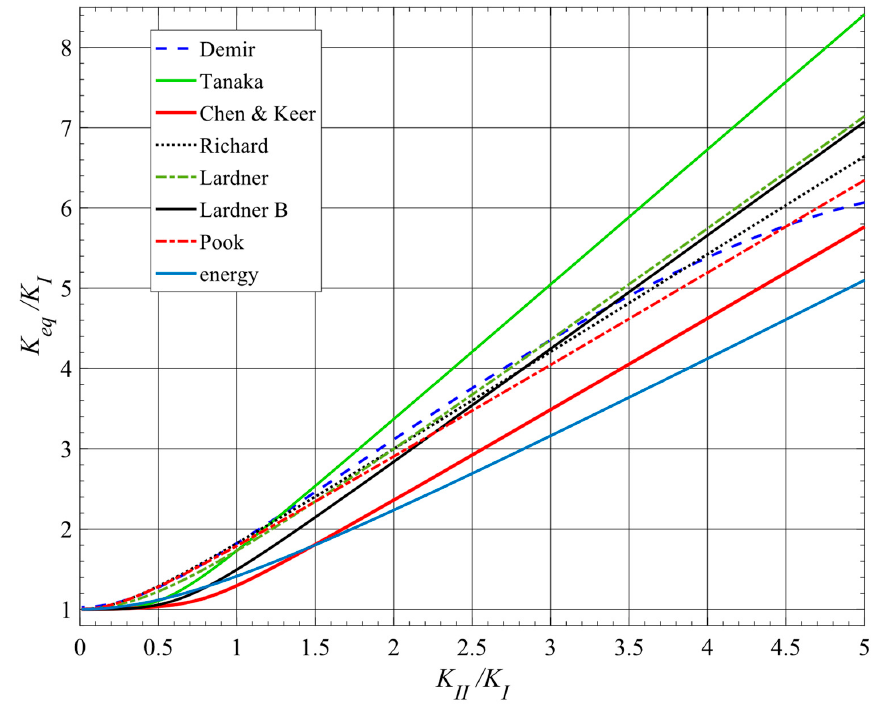
Figure 2. Non-dimensional K eq / K I as a function of K II / K I ; region K II / K I < 5. Within the range of K I and K II values of Figures 1 and 2, Demir’s approach [27,28]